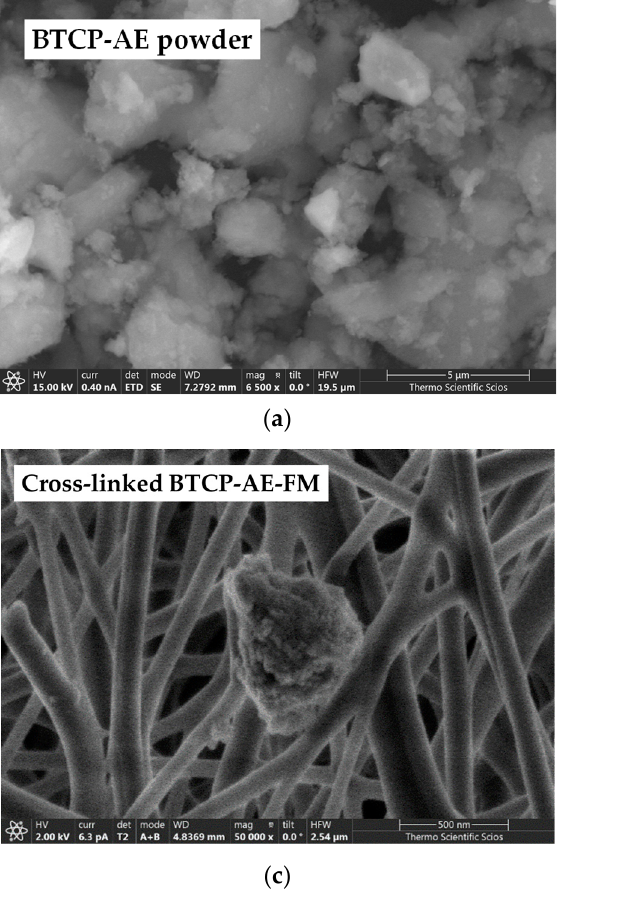
Figure 3. SEM microphotographs of the BTCP-AE powder sample ( a ) and BTCP-AE-FM sample ( c ). EDS analysis of the BTCP-AE inorganic composite powder sample ( b ) and BTCP-AE particle in the composite meshes ( d ).